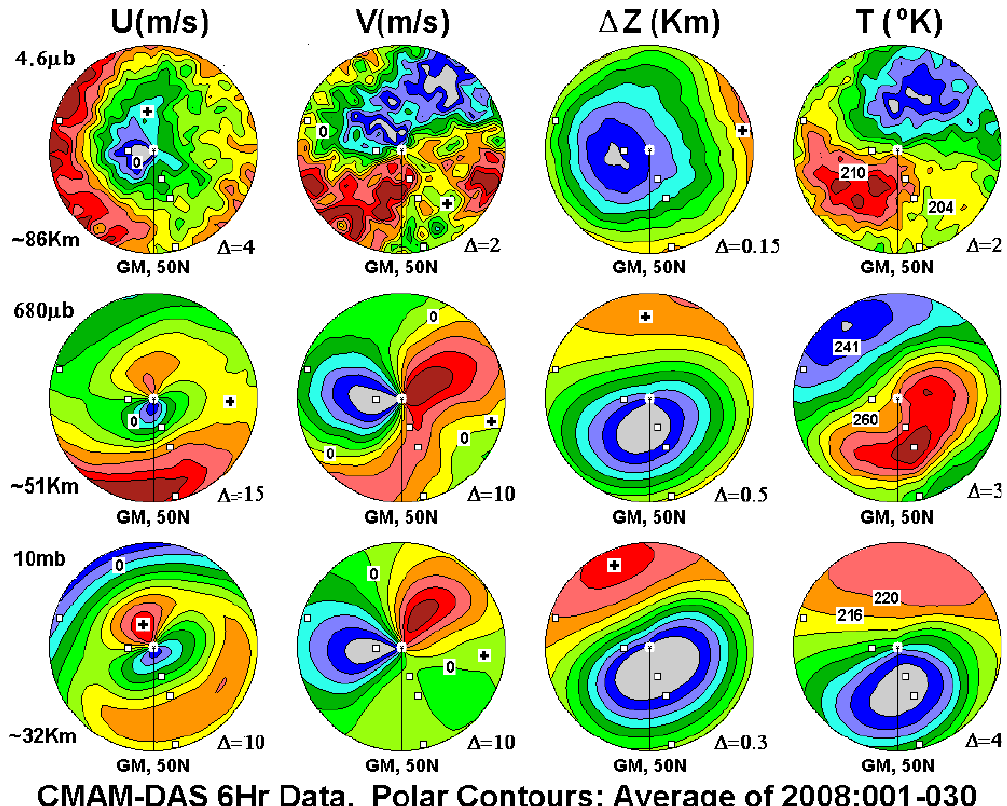
Fig. 3. Polar projection plots, with equidistant latitudes, at three constant pressure surfaces (circa 32, 51 and 86km) from the CMAM-DAS model data (see text for details). January 2008 is shown from 50 ◦ N to North Pole, with contours of winds (EW, U , zonal; NS, V , meridional) and deltas provided; geopotential height Z contours, with 1Z ; and temperature ( T ) with 1T . Details for calculations of absolute values are the same as the caption for Fig.